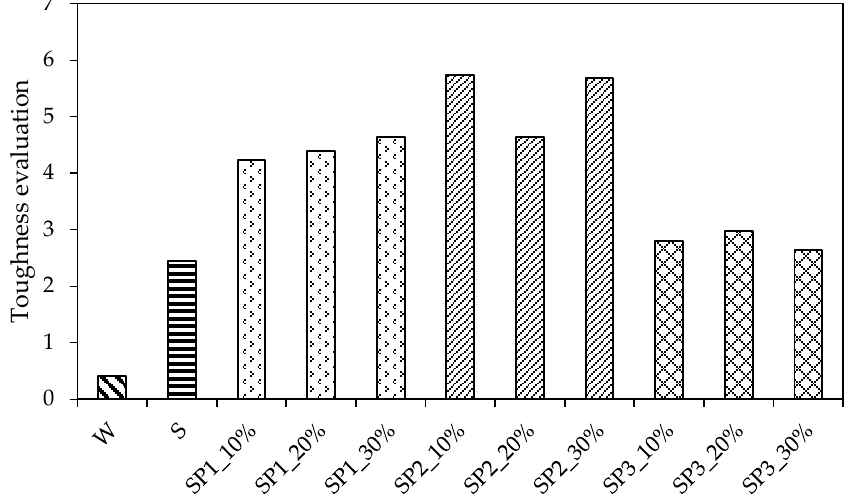
Figure 14. Comprehensive evaluation of effects of copolymers on toughness.